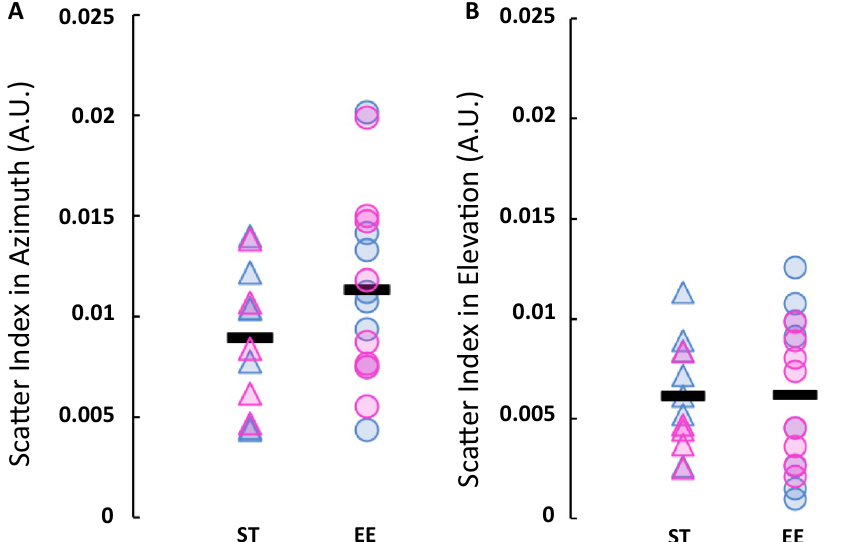
Figure 4. Scatter index in standard mice and mice reared in an enriched environment in V1. ( A ) Scatter index in azimuth in both populations, p = 0.0662 (one-tailed Welch’s t-test). ( B ) Scatter index in azimuth in both populations, p = 0.4788 (one-tailed Welch’s t-test). Individual data points represent individual animals. Pink triangle: ST female (n = 5); blue triangle: ST male (n = 7); pink circle: EE female (n = 8); blue circle: EE male (n = 8). Black line represents the